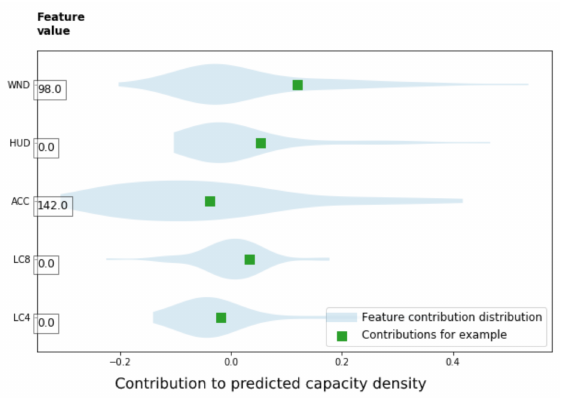
Figure 6. Feature values (left side) and contributions for the top five features for an example wind farm sampled from the test set. Variables are described in Table 2. Contributions indicate the magnitude and direction of influence for feature variables on the predicted value for capacity density. Contributions are described relative to the mean capacity density value from the training set, with positive contributions indicating that the feature value increased the prediction and negative contributions indicating the opposite. Distributions describe feature contributions taken from all samples from the testing